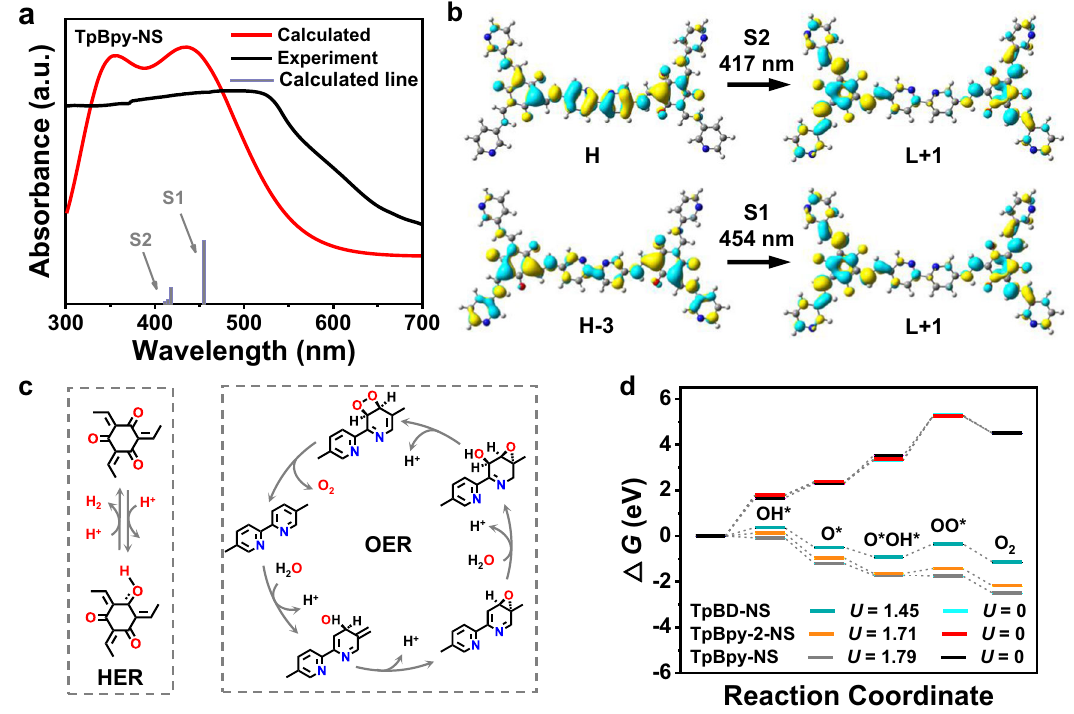
Fig. 5 | DFT calculations and proposed schematic mechanism of TpBpy-NS. a UV – Vis absorption spectra of TpBpy-NS compared with TD-DFT calculated fragment. b The TD-DFT calculated electronic transition of TpBpy-NS. c The